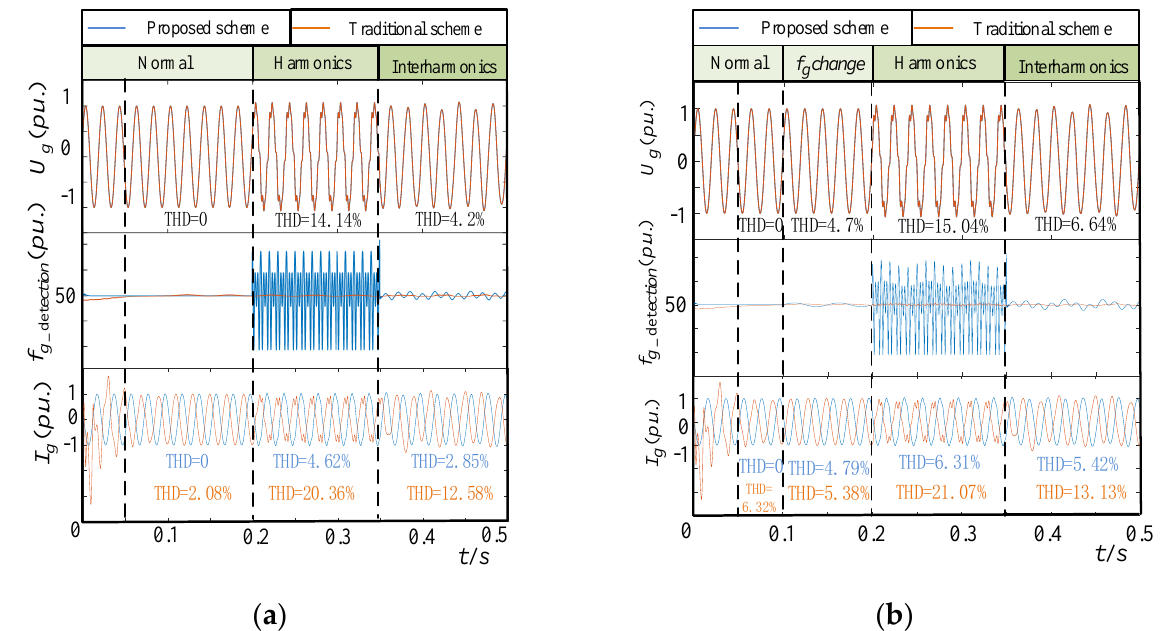
Figure 11. ( a ) Grid voltage waveform, output current of inverter waveform frequency, and feed-forward frequency detection results from phase A (measured under p.u.) when the grid voltage frequency was 50 Hz; ( b ) grid voltage waveform, output current of inverter waveform frequency, and feed-forward frequency detection results from phase A (measured under p.u.) when the grid voltage frequency varied from 46 Hz to 52.5